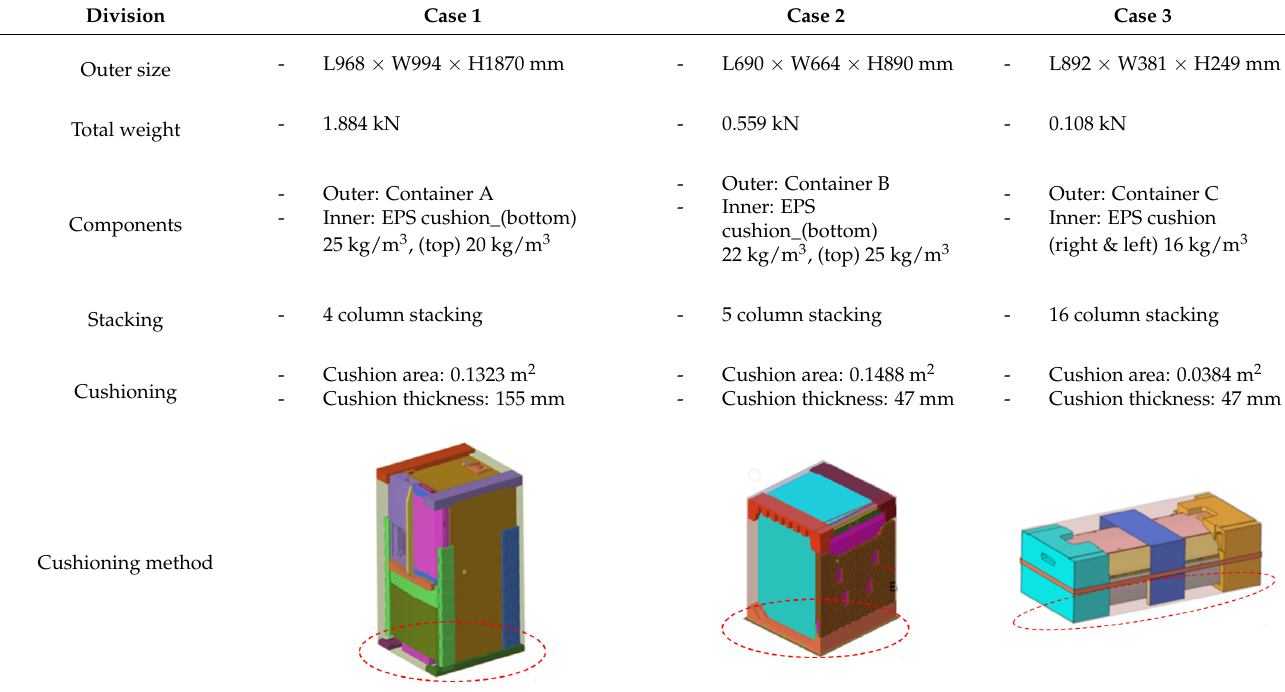
Table 1. Details of the target packages.